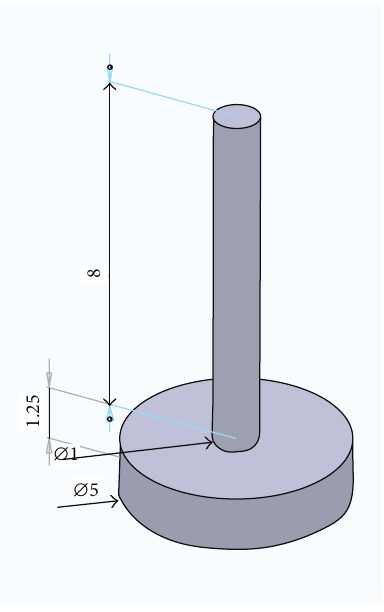
Figure 7: Dimensions for the suction caisson (meters).